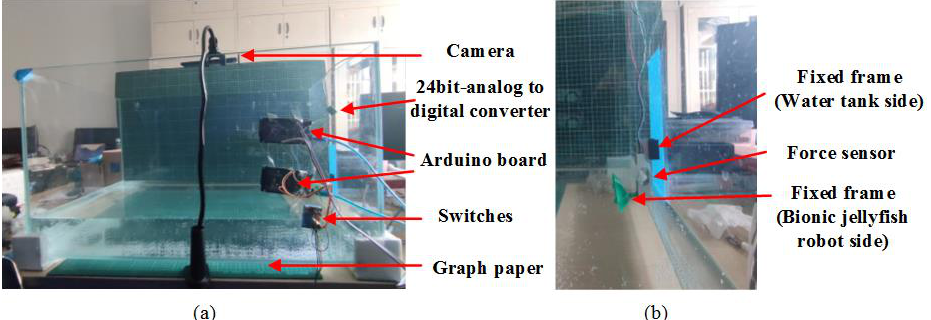
Figure 18. Experimental platform for origami flexiball inspired bionic jellyfish robot. ( a ) configura- tion of overall experiment platform; ( b ) thrust forces measurement device. of overall experiment platform; ( b ) thrust forces measurement device.